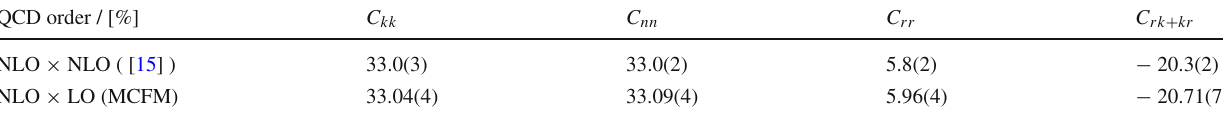
Table 3 The four largest spin correlation coefficients at NLO in decay (from Ref. [15]) and with LO in decay based on the MCFM parton-level process library QCD order /